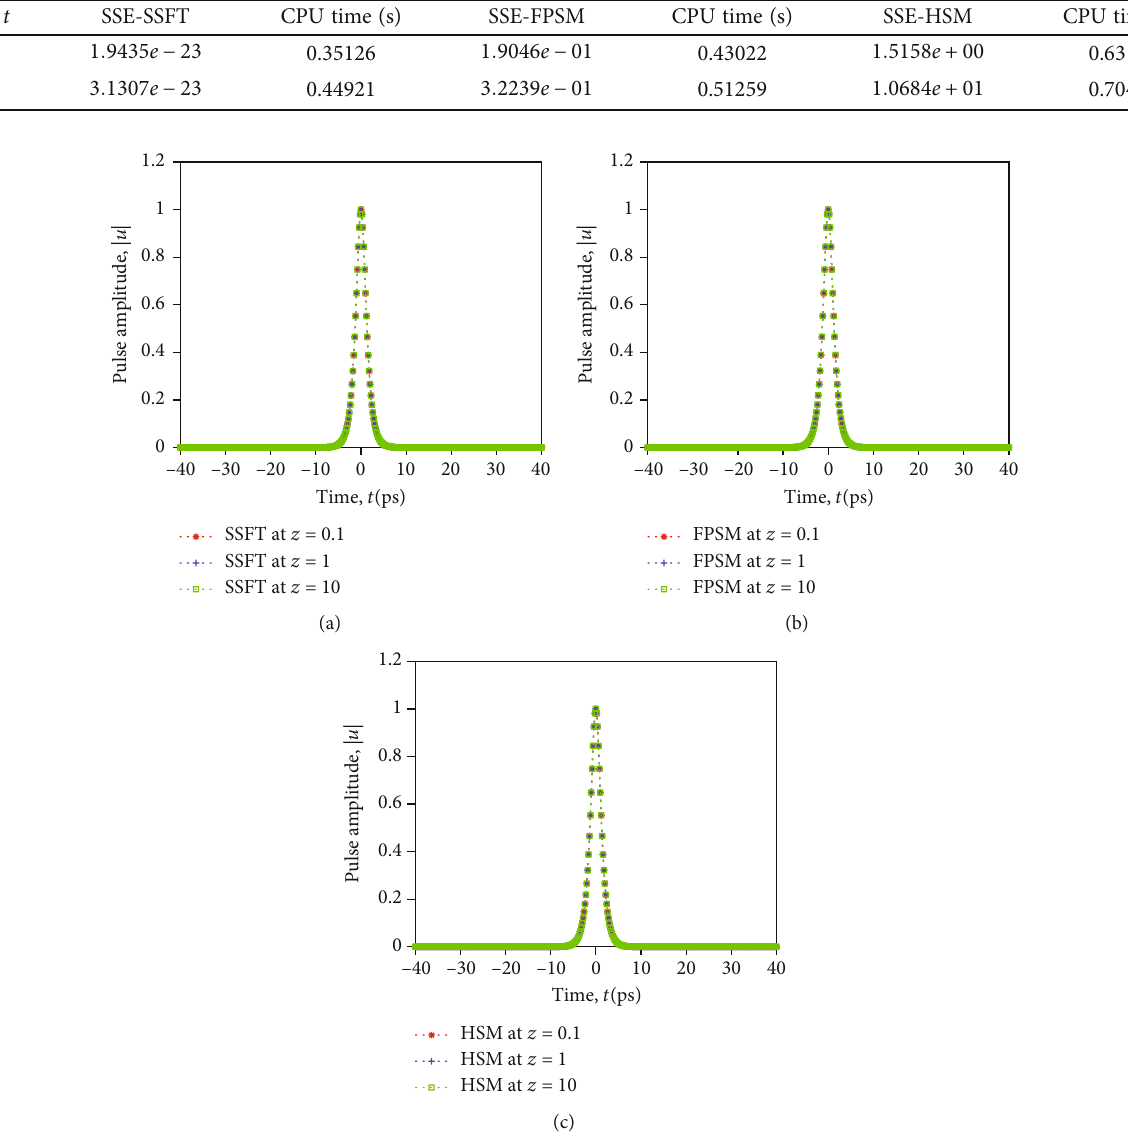
Figure 5: A comparison of the split-step Fourier transform (SSFT) (a), the Fourier pseudospectral method (FPSM) (b), and the Hopscotch method (HSM) (c) approximate solutions at for a lossless optical fi ber when the input pulse is a bright soliton at distances z = 0 : 1, 1, 10 km,